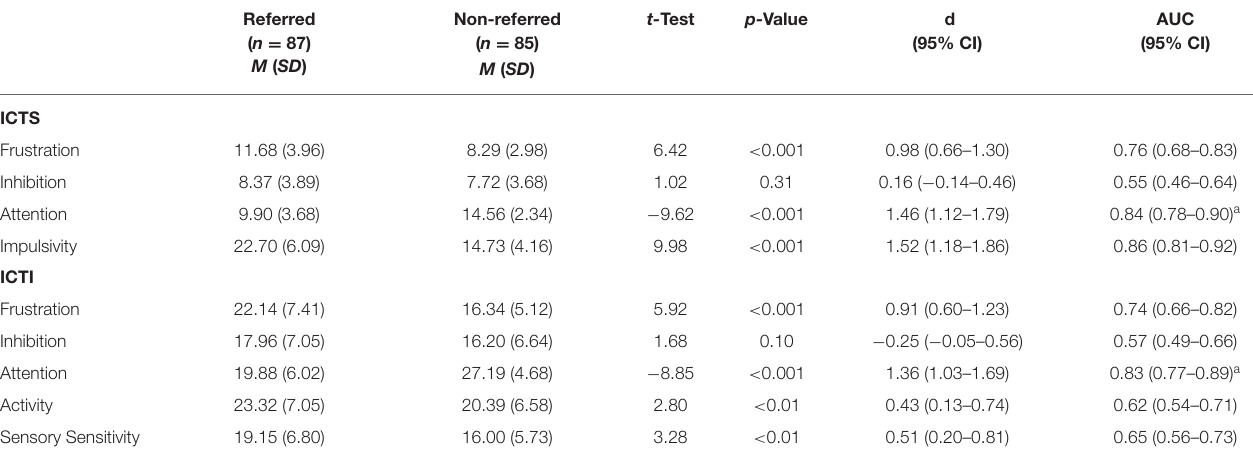
TABLE 5 | t -Test comparisons and area under the curve of the ICTS and ICTI scales for the referred and non-referred samples. Referred ( n =